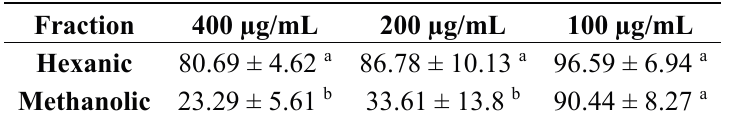
Table 1. Percentage of proliferation of M12.C3.F6 murine exposed to methanolic and hexanic fractions at different